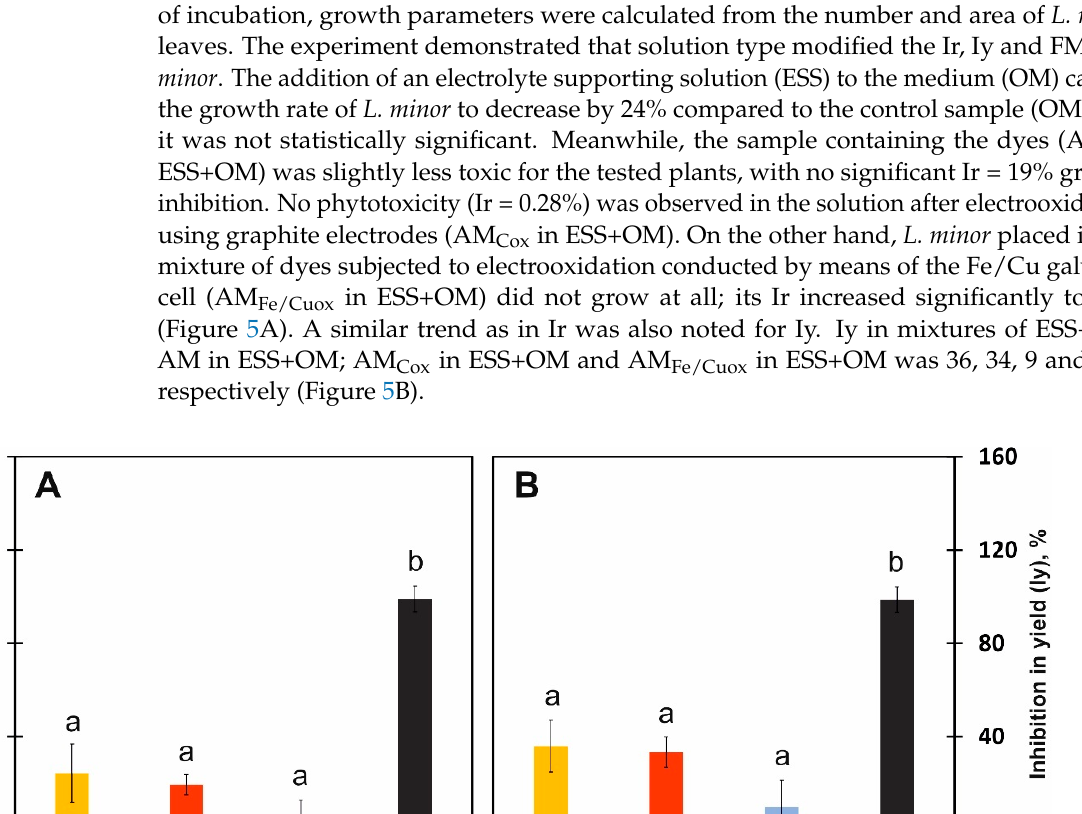
Figure 6. Fresh mass (FM) ( A ) of new fronds, dry matter content (DM) ( B ) of L. minor exposed to OM, ESS+OM; AM in ESS+OM; AM Cox in ESS+OM; AM Fe/Cuox in ESS+OM. The data points represent the mean ± SD, n = 6. Values are significantly different from the control at p < 0.01 (a–d). According to the OECD [33] and ISO [34] recommendations, the toxicity of xenobiotic toxicity can rely on evaluating the morphological features of Lemma sp. This study exam- ined the exposure effects of the L. minor on the dyes Acid Violet 90 and Acid Red 357 in an Acid Mixture before and after using two electrooxidation types. Thus, the samples con- taining 25 mg dm − 3 the dye (AM in ESS+OM), which were not subjected to electrooxida- tion, had 19% growth inhibition (Ir). However, when the dyes were subjected to electroox- idation using graphite electrodes (AM Cox in ESS+OM), no phytotoxicity of these dyes was noted. (Figure 4A,B). The phytotoxicity of xenobiotics is defined as the lowest applied concentration (LOEC) of a chemical compound, reducing the measured response by more than 20% [39]. Already, a small amount of gentian violet and Congo red not electro-oxi- dized decreases the values of Ir and Iy by 20% already in the concentration of 0.10 and 0.64 mg dm − 3 , respectively [40]. Dyes show different phytotoxicity. A high concentration (40 mg dm − 3 ) of malachite green (triarylmethane dye) high (in 77%) inhibits the relative growth rate and the number of leaves (in 85%) of L. minor [41], while methylene blue in- hibits the growth of the same plants by 46.52% [42]. Not only the type of dye but also the influence of physicochemical pretreatments applied to it affect the toxicity of dyes. During